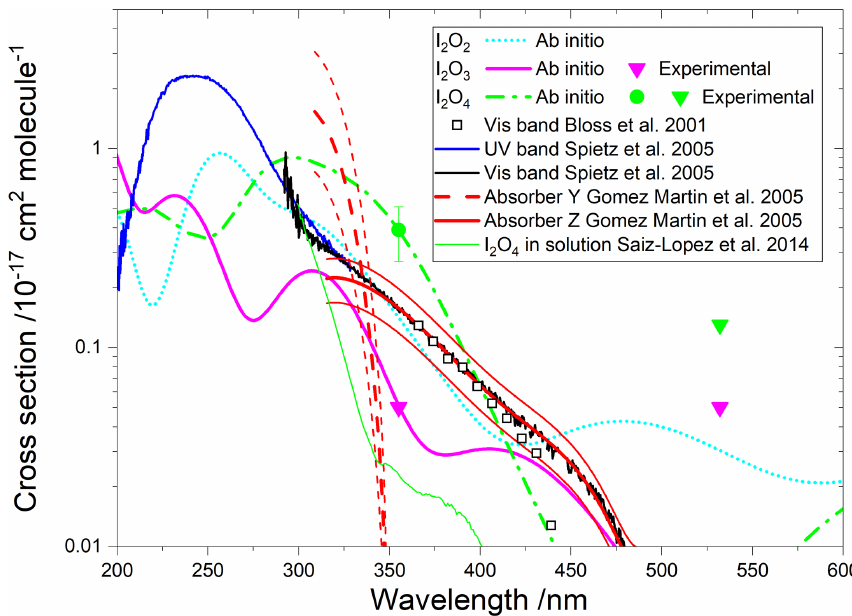
Figure 9. Absorption cross sections of I 2 O 2 , I 2 O 3 , and I 2 O 4 . The cyan, pink, and green lines correspond to the respective ab initio spectra. The pink and green symbols indicate, respectively, the measured absorption cross sections of I 2 O 3 and I 2 O 4 (triangles indicate upper limits). The empty squares correspond to an absorption band reported by Bloss et al. (2001) in 8nm interval averages for λ > 362nm. The blue and black lines correspond to absorption bands reported by Spietz et al. (2005). The latter was found to be a superposition of two absorptions with different kinetic behaviour, denoted Y (dashed red line) and Z (solid red line) (Gómez Martín et al., 2005). The thin red lines represent the uncertainties of these spectra, which mainly originate from the absolute absorption cross sections of Y and Z at 322 and 356nm, respectively. A spectrum of I 2 O 4 in solution is indicated in green (Saiz-Lopez et al., 2014).